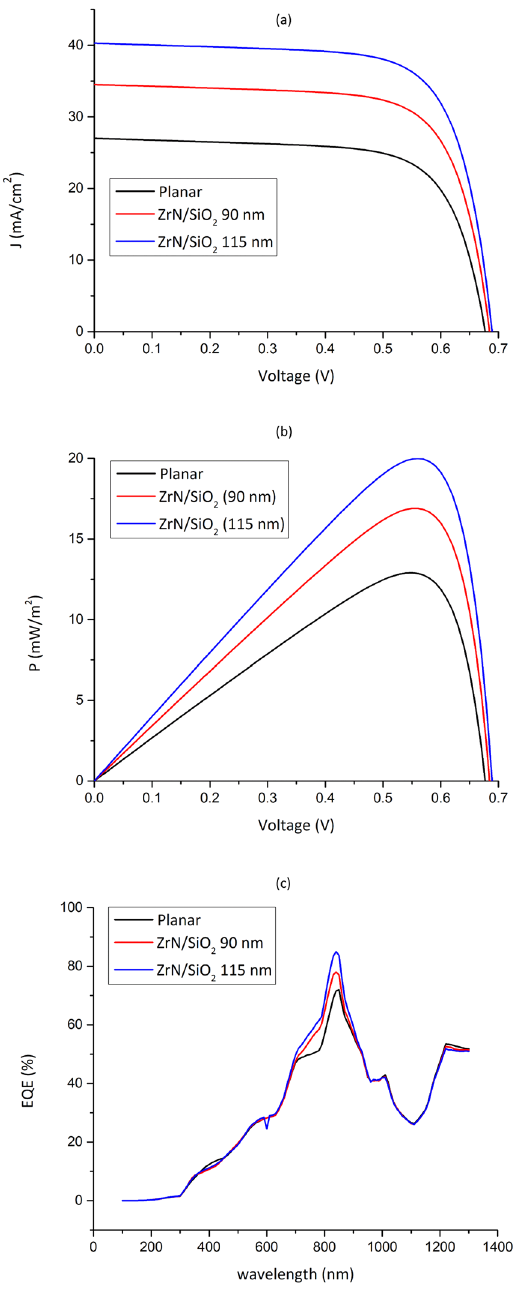
Figure 11. ( a ) J-V , ( b ) P-V , and ( c ) EQE characteristics of proposed ZrN/SiO 2 -decorated